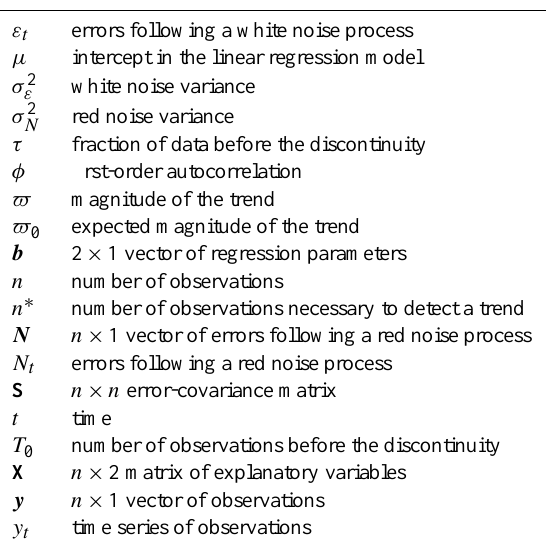
Table 3. List of